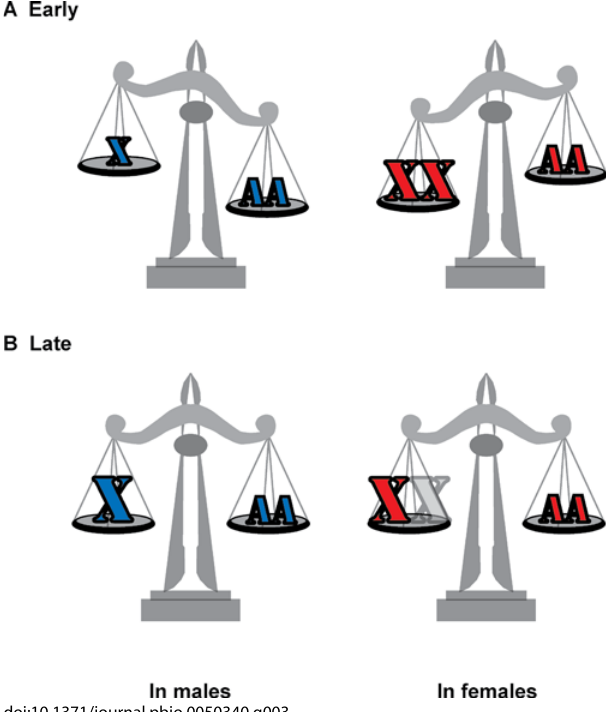
Figure 3. Dosage Compensation in Development, with Regulation in Both Sexes (A) Initially, X and AA expression are out of balance in both males and females. (B) The combination of increased X chromosome expression and X inactivation in females balances expression later in